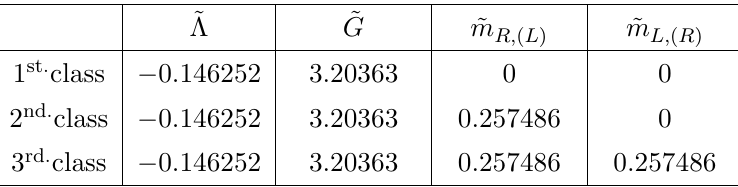
Table 1 . Fixed point structure obtained within our truncation. Those couplings which are not listed in this table vanish at the (cid:12)xed point.